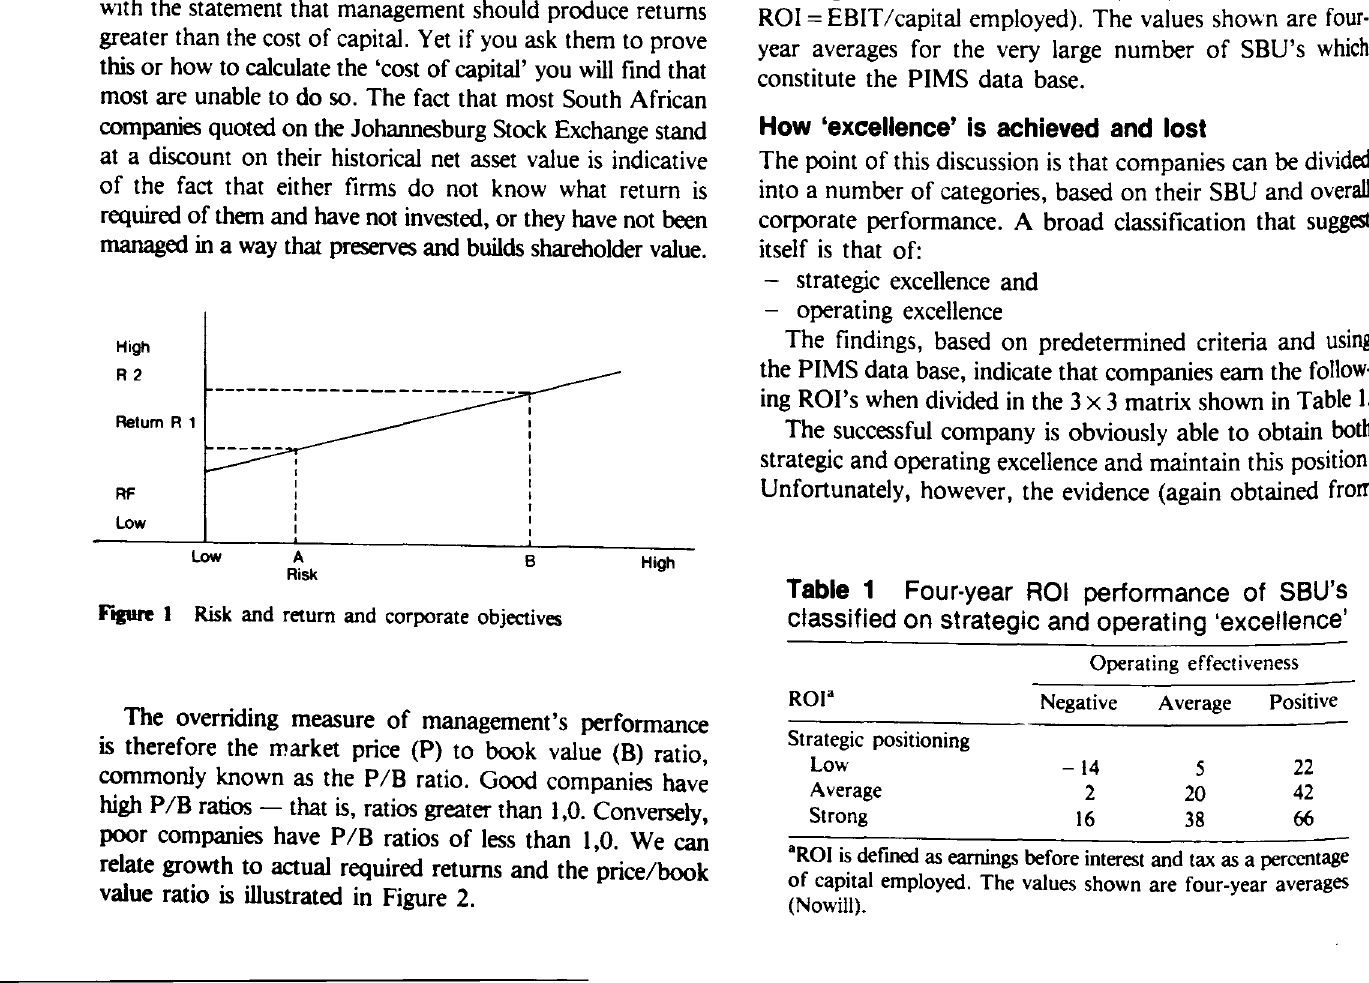
Low A Risk Risk and return and corporate objectives